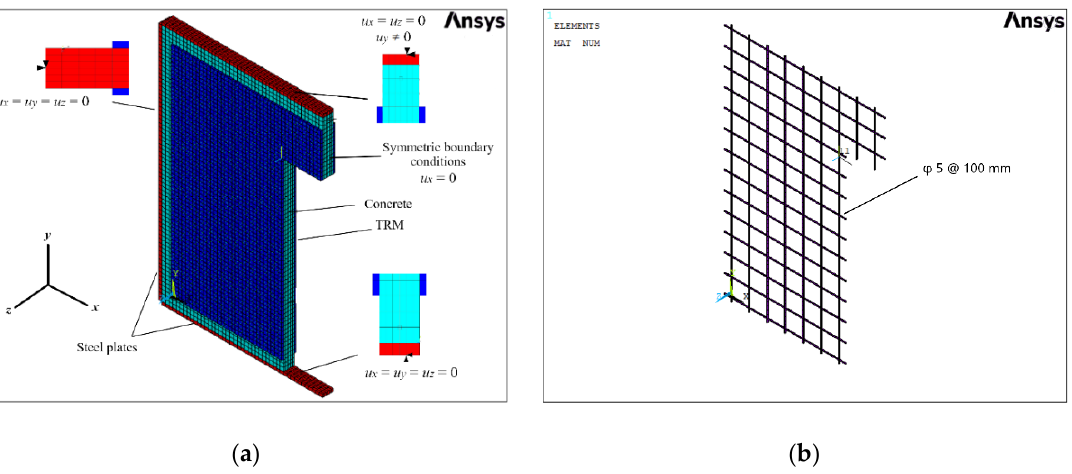
Figure 6. ( a ) Geometry and boundary conditions of the FEA models; ( b ) reinforcement details.